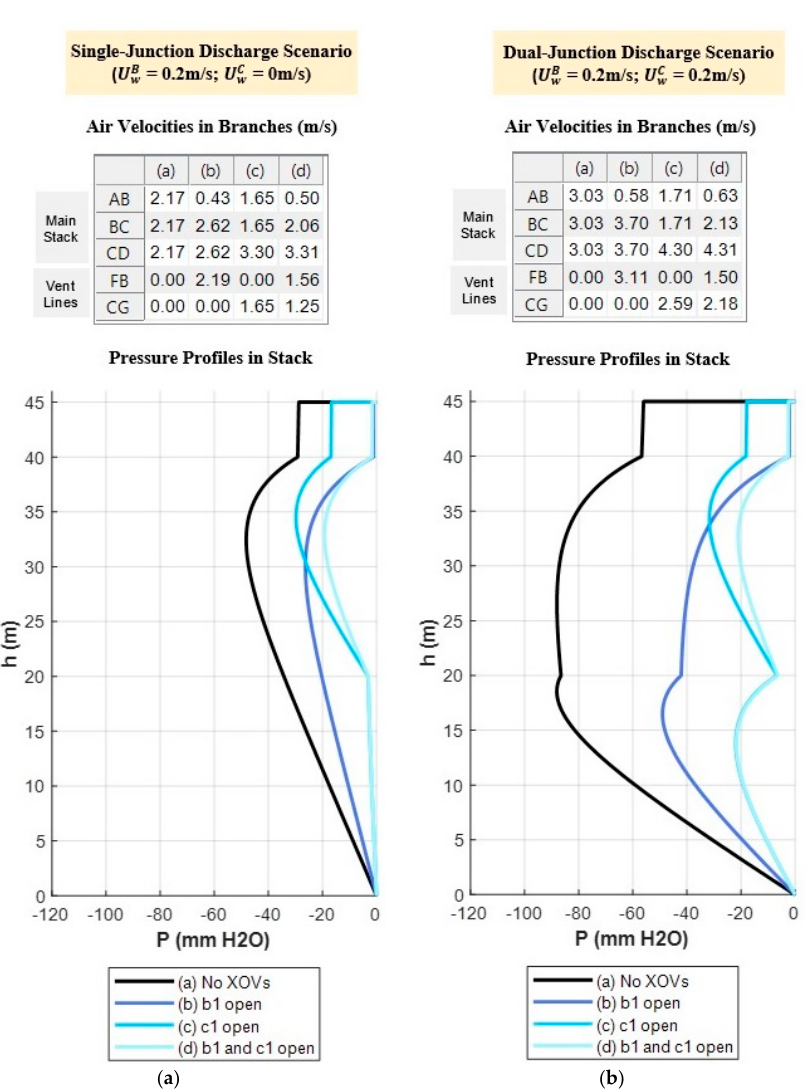
Figure 12. Preliminary case study results, for a H w = 40 m stack, with stack diameter D s = 4 inch and vent line diameter D v = 3 inch. ( a ) Single junction discharge ( b ) Dual-junction discharge.